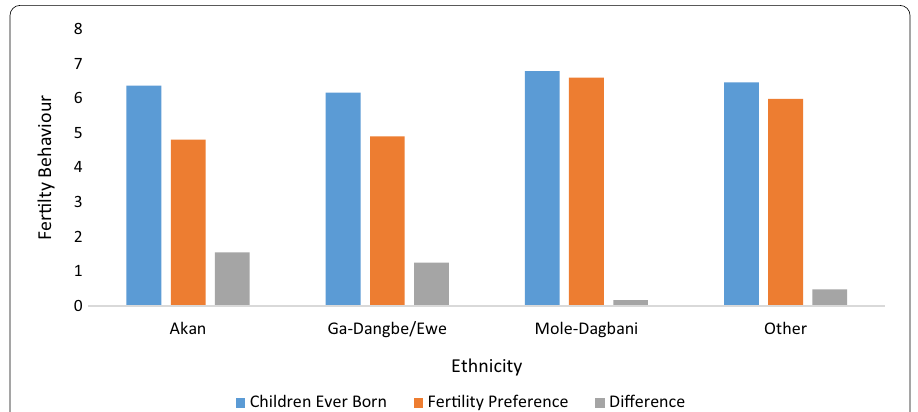
Fig. 2 Association between ethnicity and fertility behaviour (fertility preference and actual fertility) in Ghana, 2003 GDHS Source: Generated from the GDHS 2003